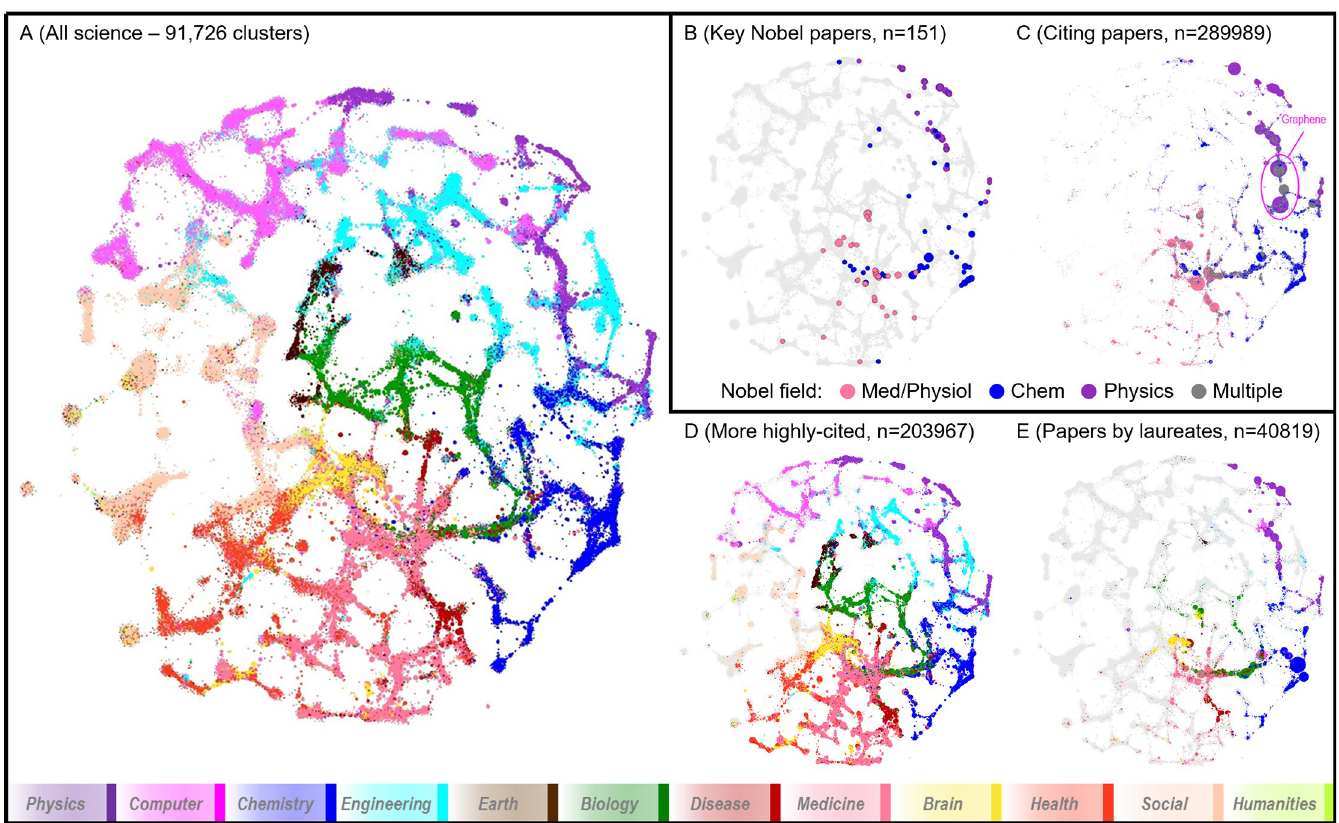
Fig 1. Location of papers in a map of science. (A) Map of science 91,726 clusters and associated large disciplines. The color legend is derived from the original construction of that map of science [15]). (B) The location of the key papers for Nobel prizes in Physics (purple), Chemistry (blue), and Physiology/Medicine (red) in 1995–2017. (C) The location of papers citing the key papers for Nobel prizes. Color legend as in panel B; grey color is used for areas that cite papers from two or more of three Nobel types. (D) The location of papers that have been more-cited than the respective Nobel key paper even though they were published within one calendar year of the Nobel key paper. Color legend as in panel A. (E) the location of the entire career-long publication record (40,819 papers) published by scientists awarded Nobel prizes in Physics, Chemistry, and Physiology/Medicine 1995–2017. Color legend as in panel A.